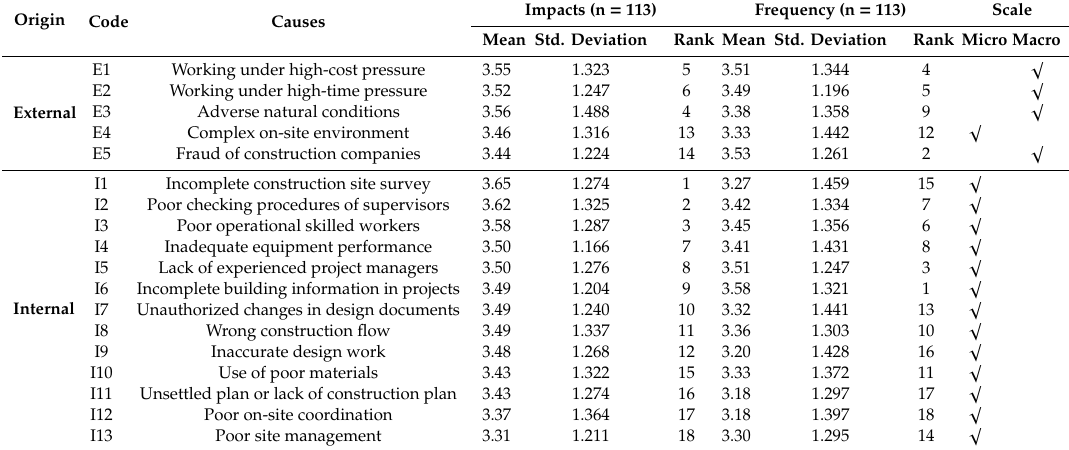
Table 7. Impact rankings, frequency rankings, origin, and scale of